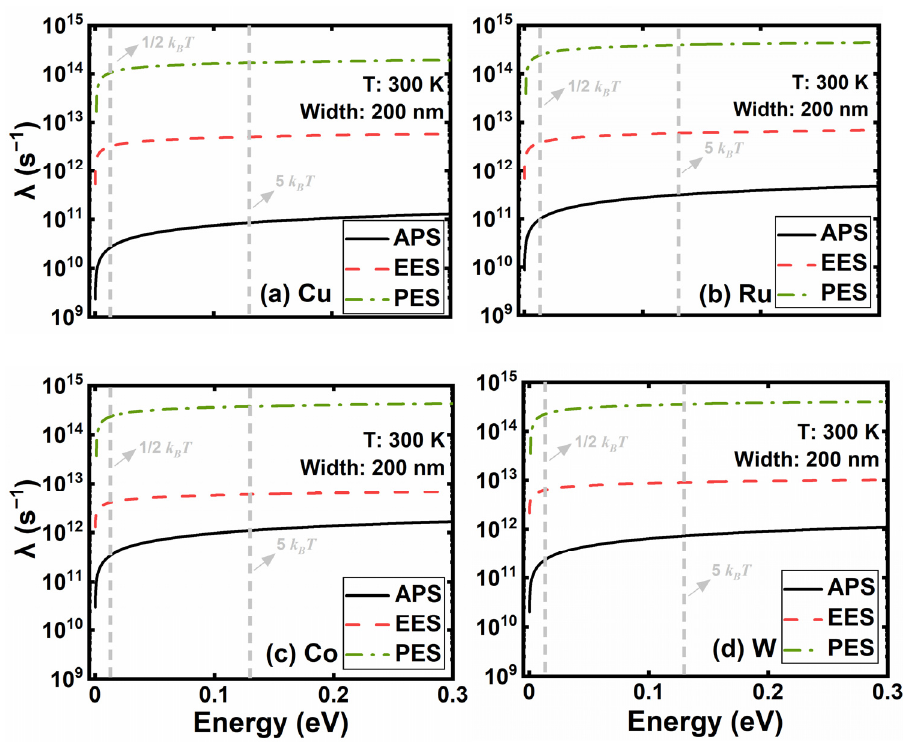
Figure 3. The scattering rates of bulk ( a ) Cu, ( b ) Ru, ( c ) Co, and ( d ) W with the electron energy ranging up to 0.3 eV.